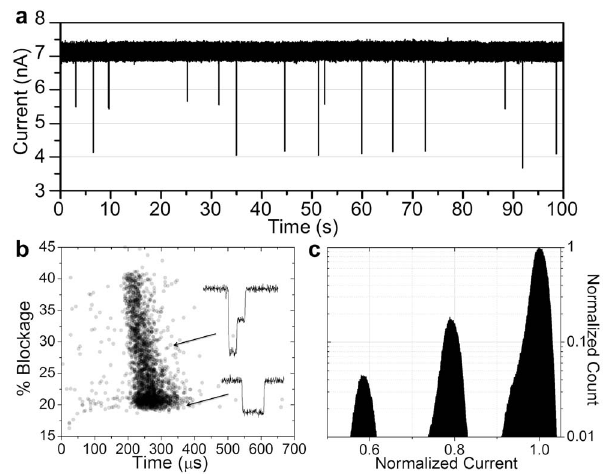
Figure 4. DNA Translocations. a) Ionic current trace showing multiple DNA translocation events through a , 6.4-nm pore in a 10-nm- thick SiN x membrane. Experiments performed with 10 m g/mL of 5-kb DNA fragments in 3.6 M LiCl pH8, at 200 mV using an Axopatch 200B. Data sampled at 250 kHz and low-pass filtered at 100 kHz. b) Scatter plot of the normalized average current blockade (0% presenting a fully opened pore, and 100% a fully blocked pore) versus the total translocation time of a single-molecule event. Each data point represents a single DNA translocation event. The majority of the events are unfolded. There are very few anomalously long events, indicating weak DNA-pore interactions. The inset shows ionic current signatures of two single-molecule translocation events, passing in a linear and partially folded conformation. c) Histogram of the current level revealing the expected quantization of the amplitude of current blockades. Quantized levels corresponding to zero, one, two dsDNA strands in the nanopore are clearly